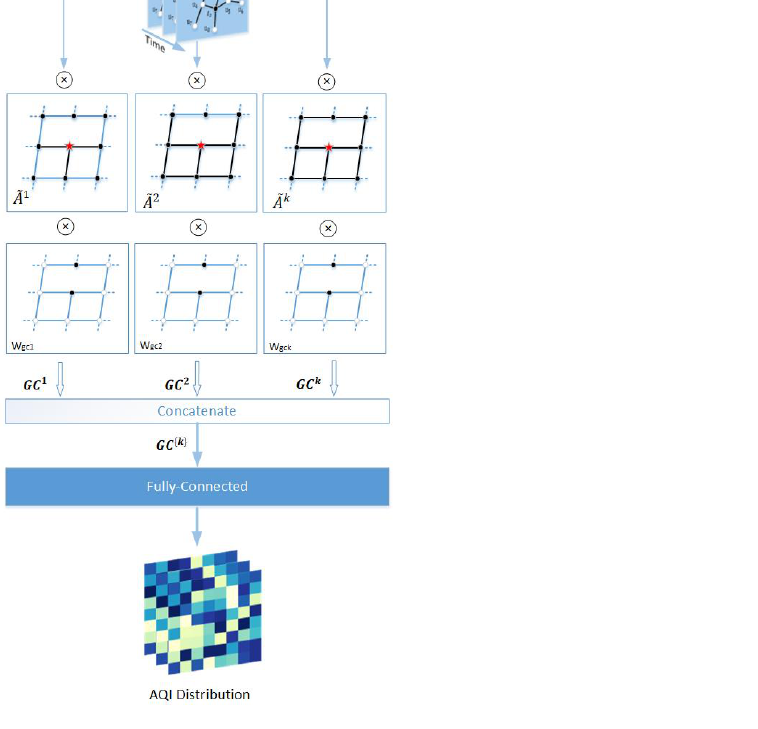
Figure 5. The architecture of proposed higher-order convolutional network. The multi-hop neighbor with respect to a node (the red star) is the nodes that can be reached by the black edges.